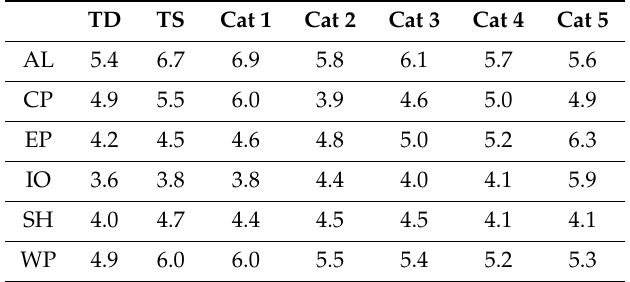
Table 2. Averaged motion speed at each intensity category over each TC basin (m s − 1